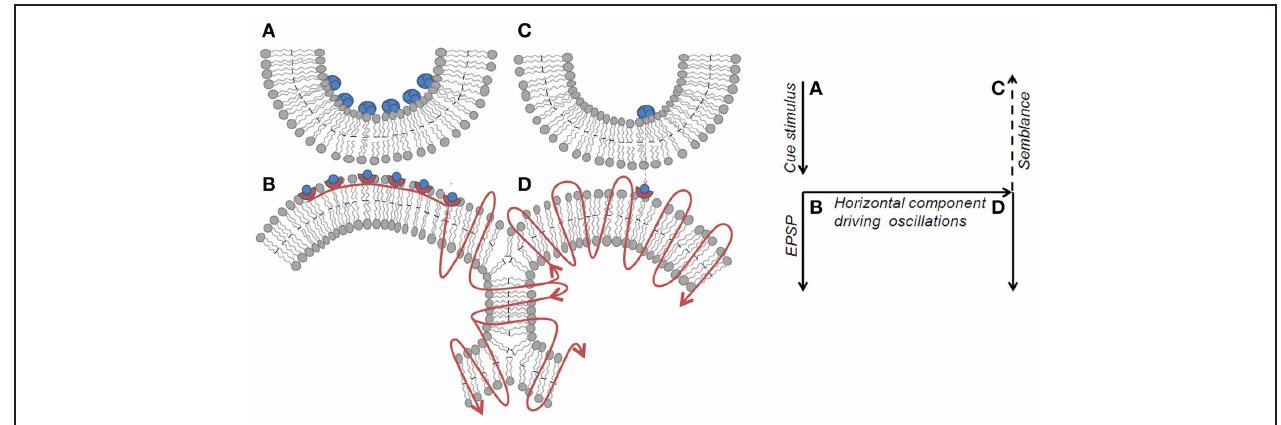
FIGURE 4 | Spread of activity through an inter-postsynaptic functional LINK. Left panel: Diagram showing the spread of action potential induced EPSP from postsynapse B through the hemi-fused inter-postsynaptic membrane segment toward the opposite postsynapse D (shown by the curved lines with arrows pointing in the direction of spread of action potential). Unidirectional chemical transmission at the chemical synapses and unidirectional quantal release of single synaptic vesicles (in blue-filled circles) from presynapses inducing miniature EPSP (mEPSP) at the postsynapses sets the stage for the systems feature of semblance formation. When activity arrives at postsynapse D laterally through the hemi-fused area from postsynapse B, it induces a cellular hallucination (semblance) at postsynapse D that the activity is coming from its presynapse C. This is viewed as a